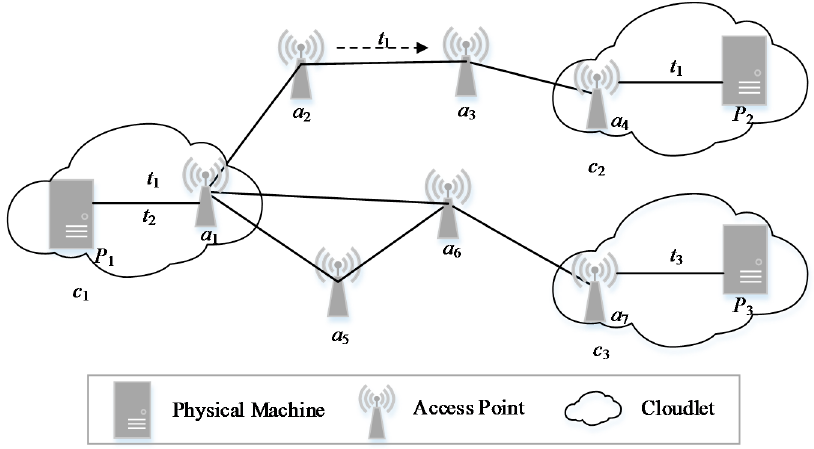
Figure 1. An example of cloudlet layout in the wireless metropolitan area network .